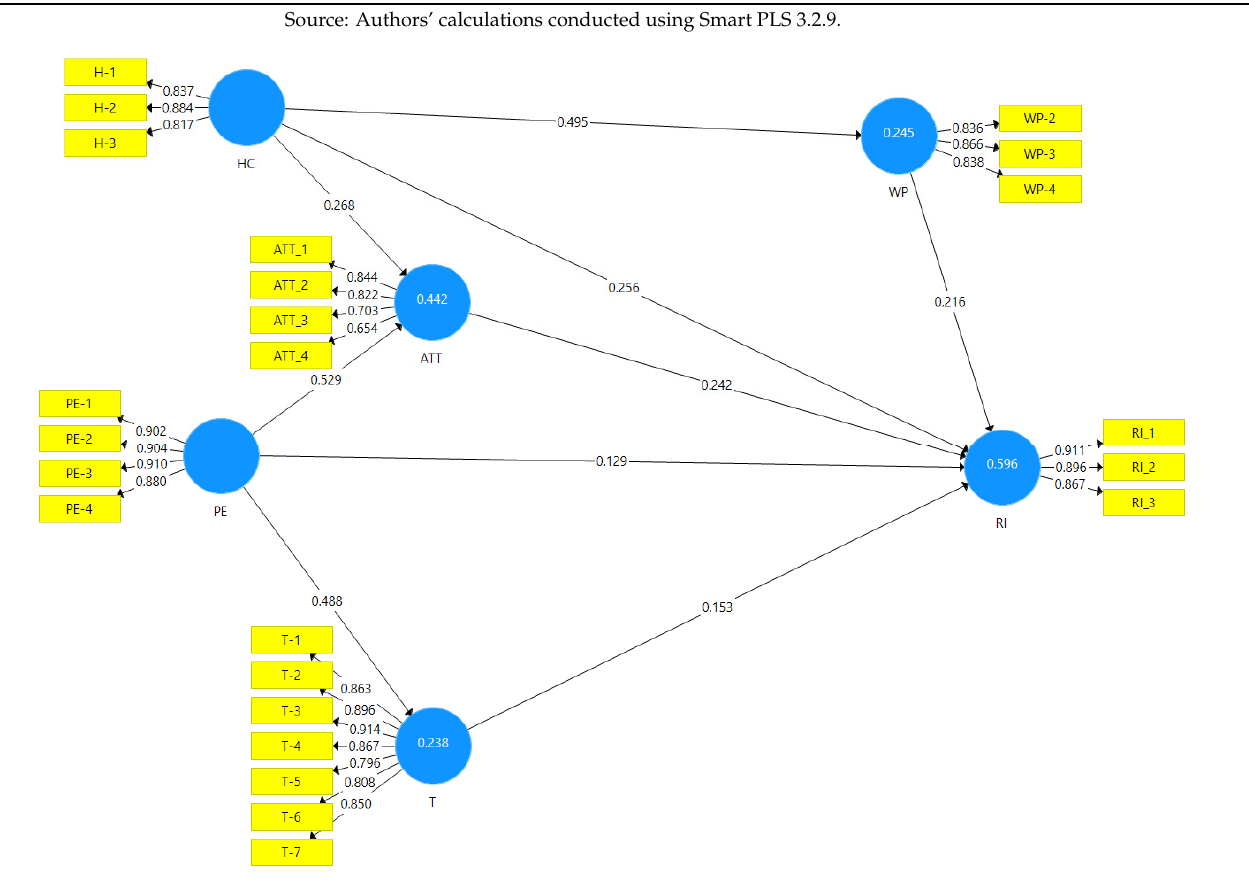
Figure 2. Run model. Figure 2. Run Table 6. Path coefficients and fitness indices for the structural model.